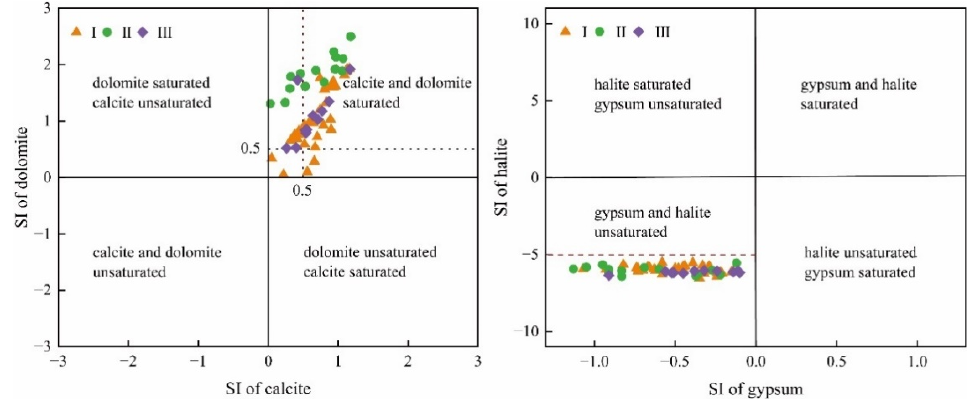
Figure 9. Mineral saturation index of karst groundwater in Taiyuan Formation.